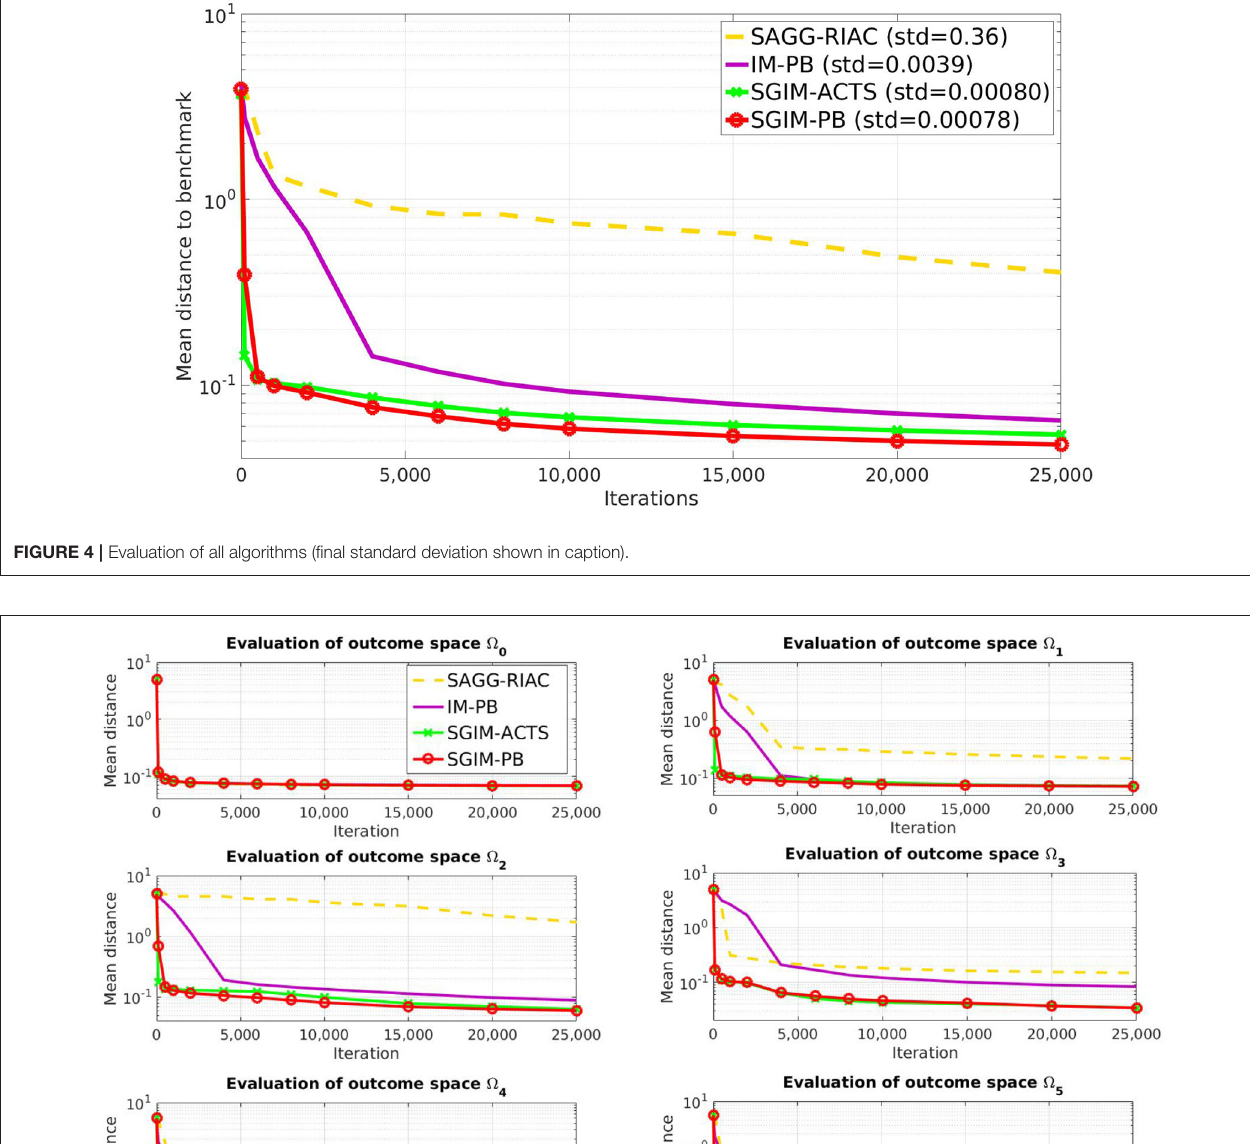
procedures might be tricky, as the outcomes used don’t take into account the motion trajectory but merely its final